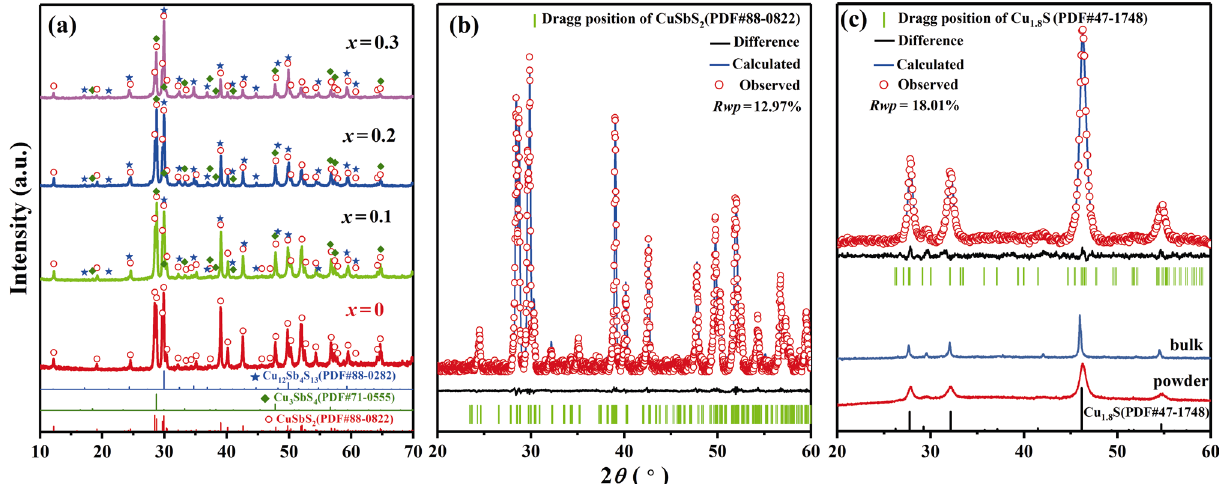
Fig. 1 (a) XRD patterns of the bulk samples with the mole ratio of (1– x )CuSbS 2 – x Cu 1.8 S ( x = 0, 0.1, 0.2, 0.3), (b) Rietveld refinement of x = 0 bulk sample, and (c) XRD patterns and Rietveld refinement of Cu 1.8